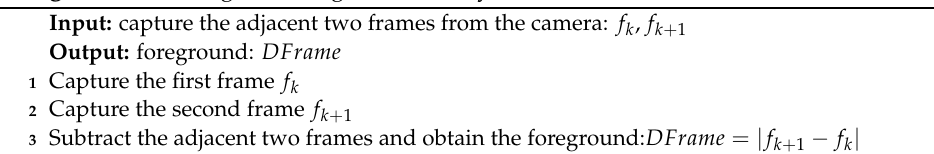
Algorithm 1: Foreground segmentation by frame difference